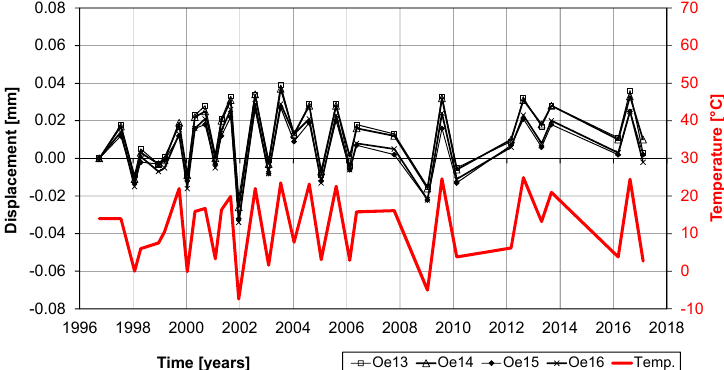
Figure 27. Displacement measurements over the last 20 years. Measurements Oe 13 and 14 are on the strip (at mid-length of strip) and CH 15 and 16 on the concrete surface similar as can be seen on Figure 25.